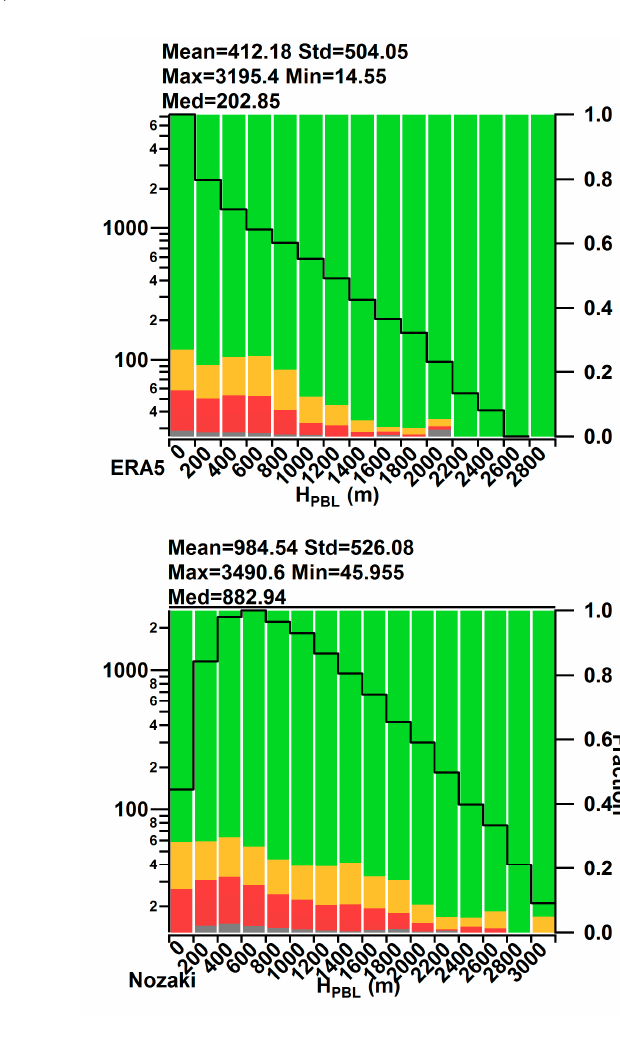
Figure 6. The probability distribution diagram of BLH and the proportion of different levels of PM 2.5 pollution from the four BLH calculation methods. (The left vertical axis is BLH, the right vertical axis is the probability distribution for different levels of PM 2.5 pollution; black short line is the number of occurrences of BLH in different interval, corresponding to the left logarithmic co-ordinates; the color bars are the proportion of different levels of PM 2.5 pollution, corresponding to the right coordinates; the upper right or left corner of each panel shows the statistical parameter of BLH).